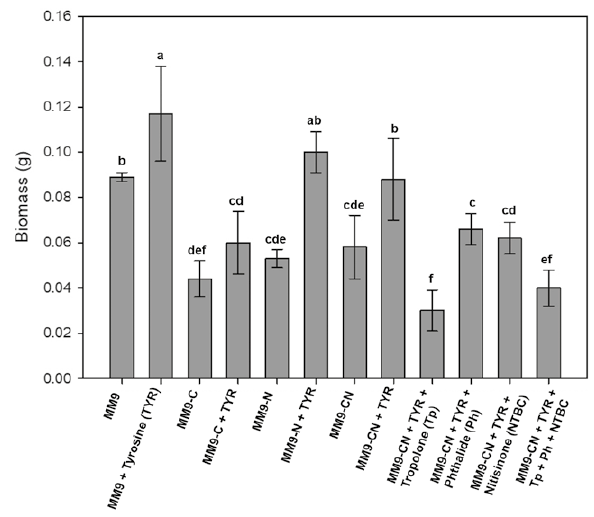
Figure 6. Mean weights of Lasiodiplodia gilanensis biomass in the presence of tyrosine and melanin inhibitors. Bars indicate standard deviations. Means accompanied by the same letters are not signifi- cantly different (α <